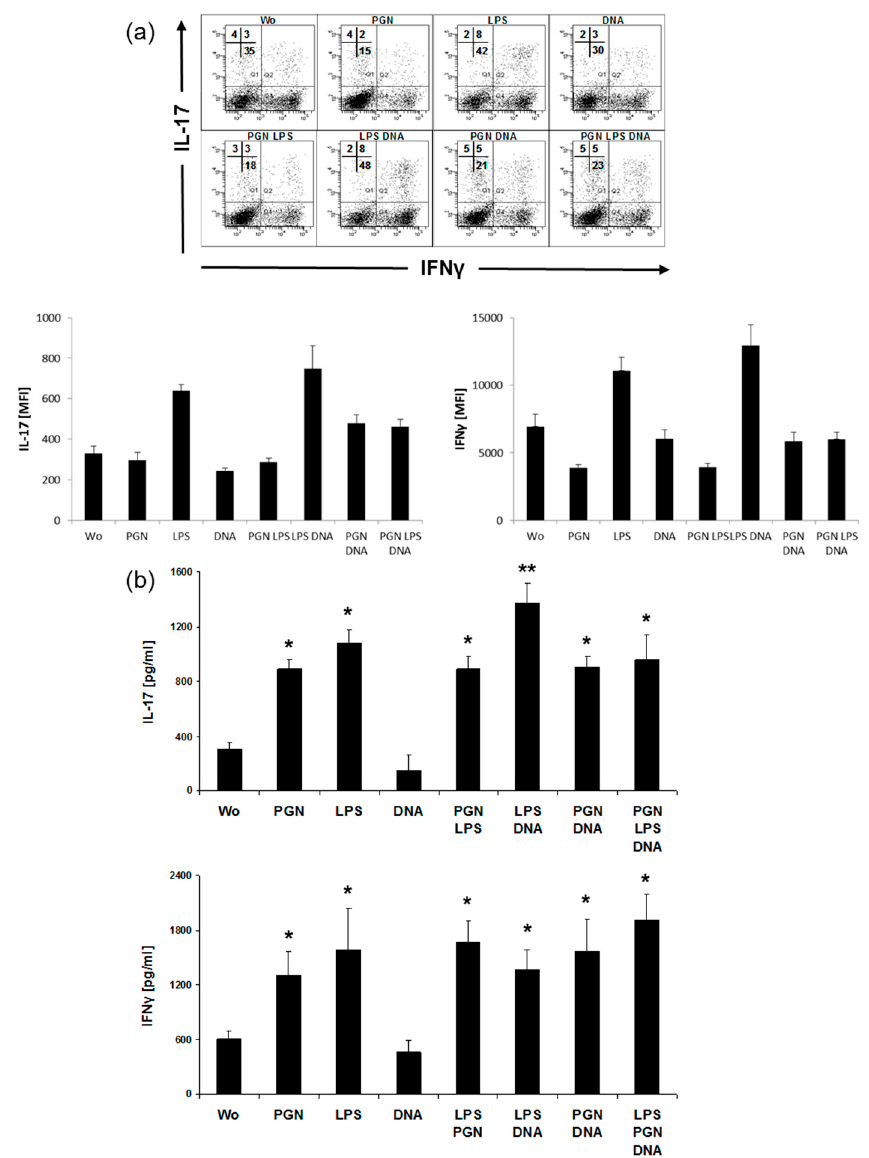
Figure 5. Intracellular and supernatant-derived IL-17 and IFN- γ in CD4 + T cells from TLR-stimulated cocultures. MoLC were stimulated with single and combinations of TLR agonists 20 µ g/mL PGN, 1 µ g/mL LPS and 5 µ g/mL DNA for 48 h. The stimuli were removed by washing and LCs further cocultured with allogeneic CD4 + T cells. ( a ) Intracellular costaining of IL-17 and IFN- γ by flow cytometry in 5 days-cocultured cells. One experiment out of four with different donors and similar results is shown. Numbers represent the percentage positive cytokine expression among CD4 + T cells; Bars indicate mean fluorescence intensity (MFI) ± SD from intracellular FACS for IL-17 and IFN- γ . ( b ) ELISA detects IL-17 and IFN- γ after 5 days in the supernatants. Bars represent results of experiments with four different donors (mean ± SD) and include data from the same donor as used in flow cytometry ( a ). Differences of values for cytokines after stimulation were analyzed for statistical significance and compared to control (without, wo); * p ≤ 0.05, ** p ≤ 0.01.